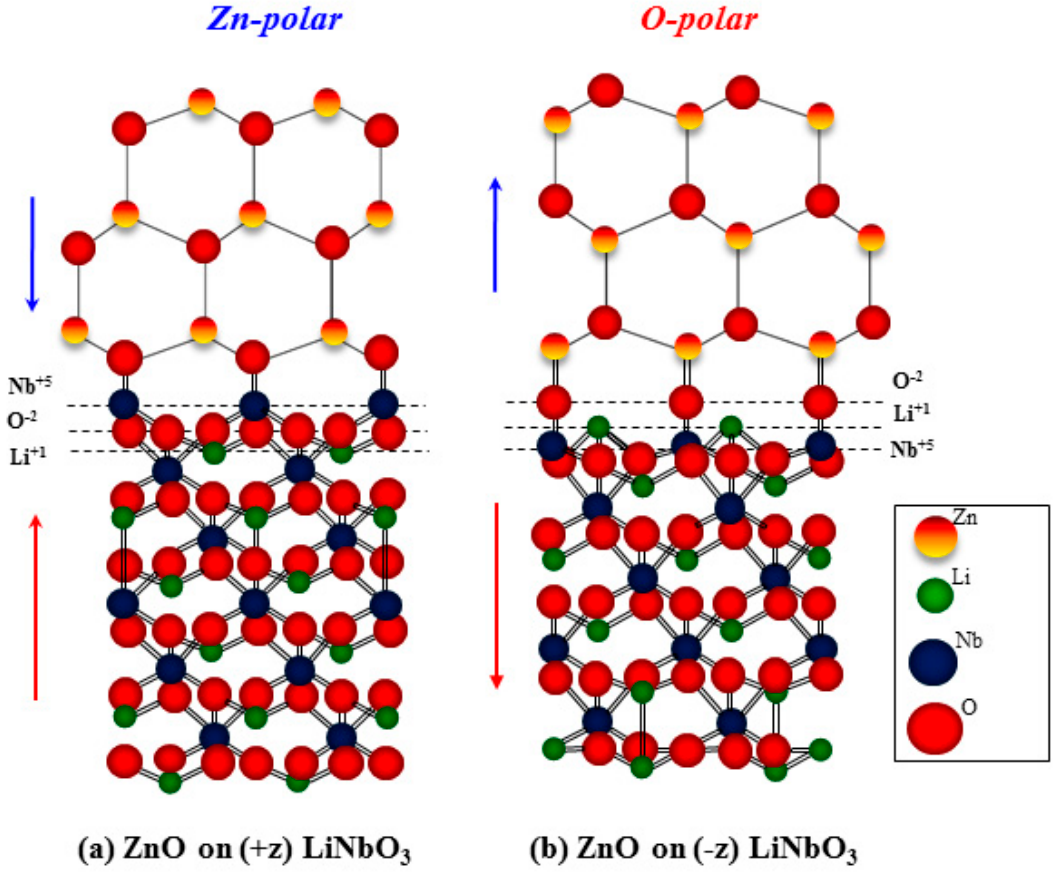
Figure 5. Schematics of the atomic arrangements of the ZnO films grown on ( + z) LiNbO 3 ( a ) and (-z) LiNbO 3 ( b ), resulting in Zn-polar ZnO and O-polar ZnO, respectively.